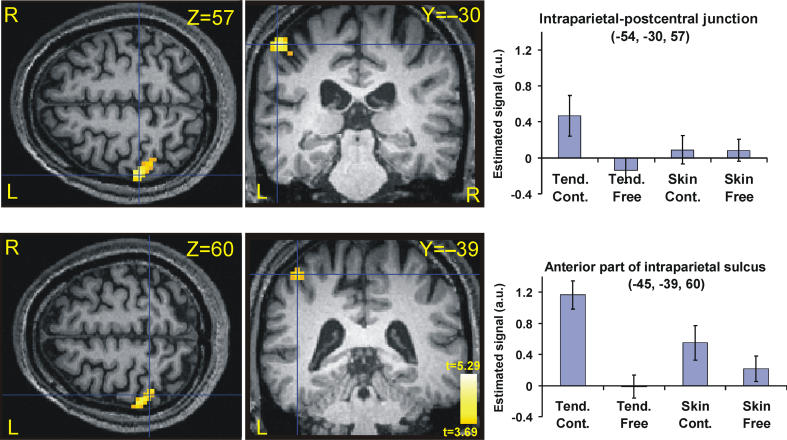
Activity that Reflects the Illusion that the Waist Was Shrinking (Interaction Effect: p < 0.001 Uncorrected)Top row: Activation of the cortices lining postcentral sulcus near its junction with the intraparietal sulcus. Lower row: Activation of cortex lining the intraparietal sulcus. The activations (colour) are superimposed on a normalized high-resolution T1-weighted image of a representative participant (black and white). The coordinates for the displayed slices are shown, and the crossing of the blue lines indicates the location of the activation peaks. R and L denote the right and left hemispheres, respectively. The plots to the right show the contrast estimates with the standard bars corresponding to the standard error (SE).